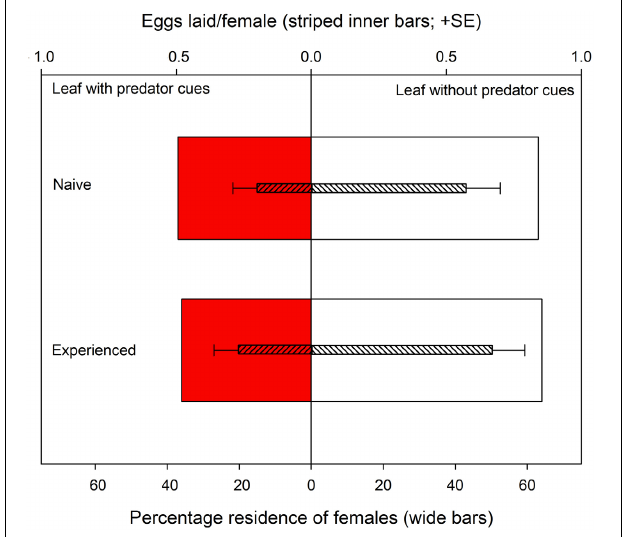
FIGURE 3 | Site preference (wide bars) and oviposition (striped inner bars; eggs per female per leaf disc during 240min) of predator-naïve and -experienced spider mite females given a choice between two connected leaf discs, one with and one without predatory mite cues.